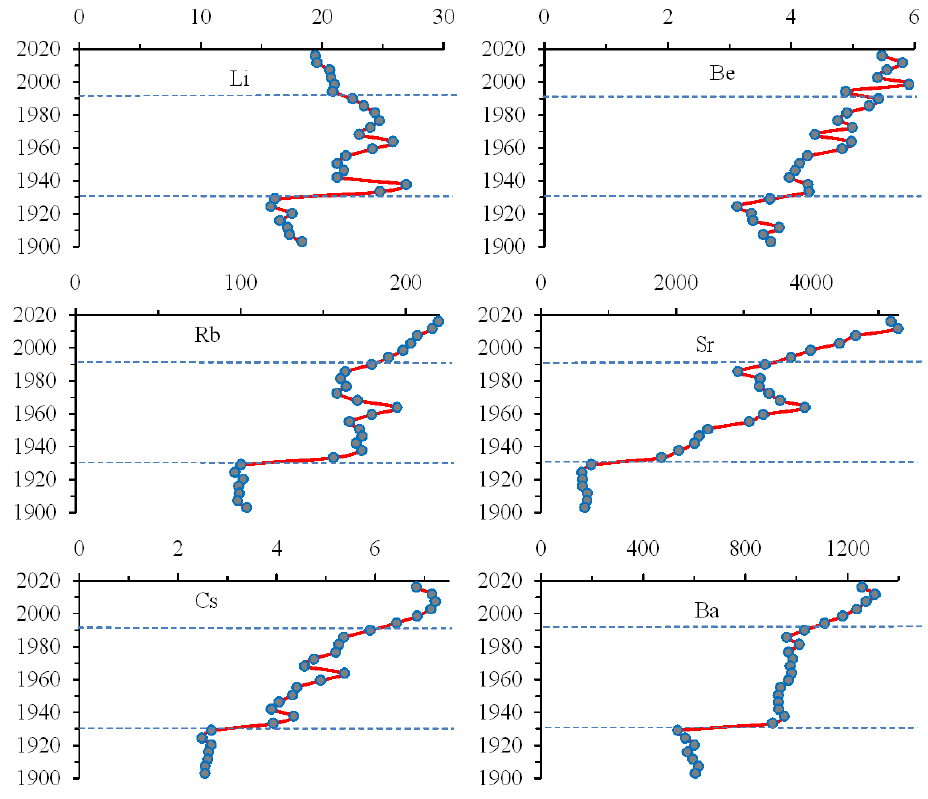
Figure 6. Vertical distribution of the content (µg/g) of alkali and alkaline earth metals in the sediments of Lake Bolshoy Vudjavr.